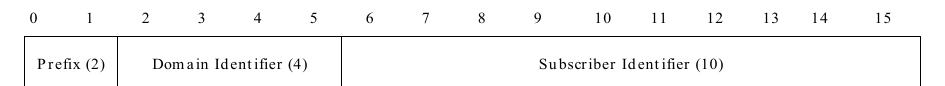
Figure 8. HID format.